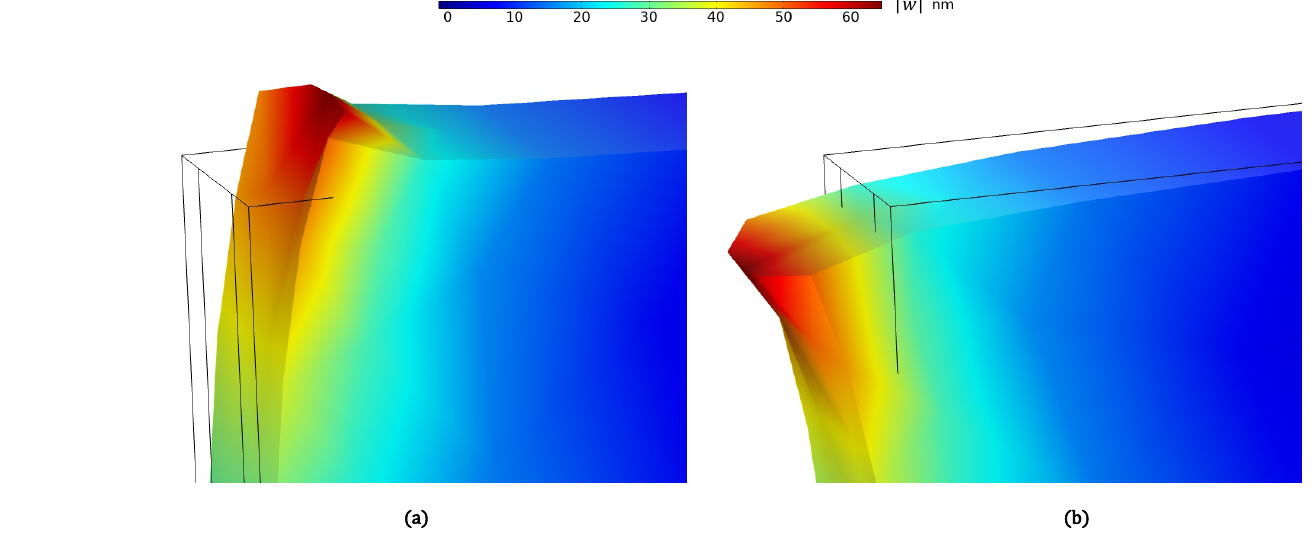
(b) Figure 3. Finite element analysis (FEA) of the deformation under ( a ) positive and ( b ) negative in-plane displacement, u .